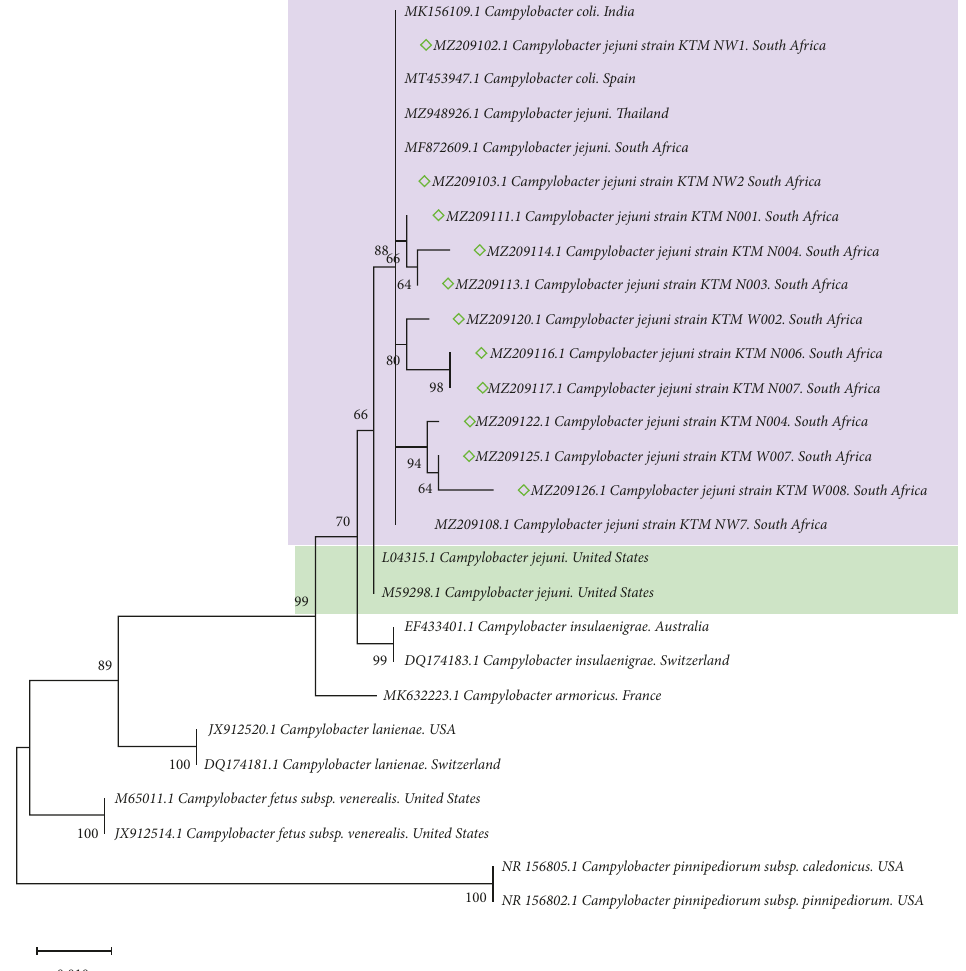
Figure 2: Phylogenetic tree of the 16S rRNA gene constructed by using the maximum likelihood method and Kimura 2-parameter model among Campylobacter species. The node numbers represent the levels of bootstrap support based on 1000 replicates. The scale bar represents 0.010 substitutions per nucleotide position. All positions containing gaps and missing data were eliminated from the dataset (complete deletion option). The diamonds indicate C. jejuni isolates of the current